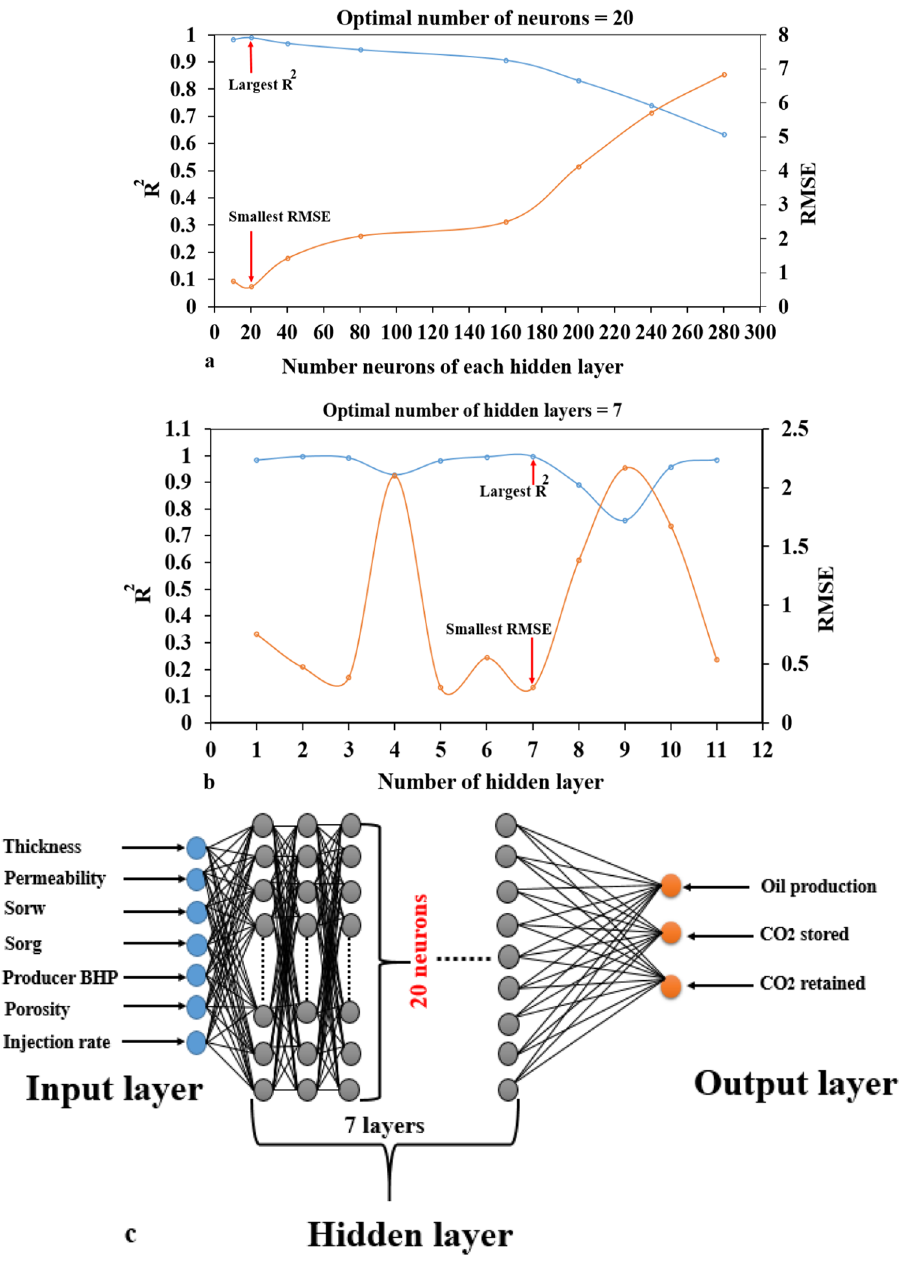
Figure 4. The effect of neuron and hidden layers to ANN models. ( a ) The optimal neurons of each layers. ( b ) The optimal number hidden layer. ( c ) The optimal architecture of ANN prediction